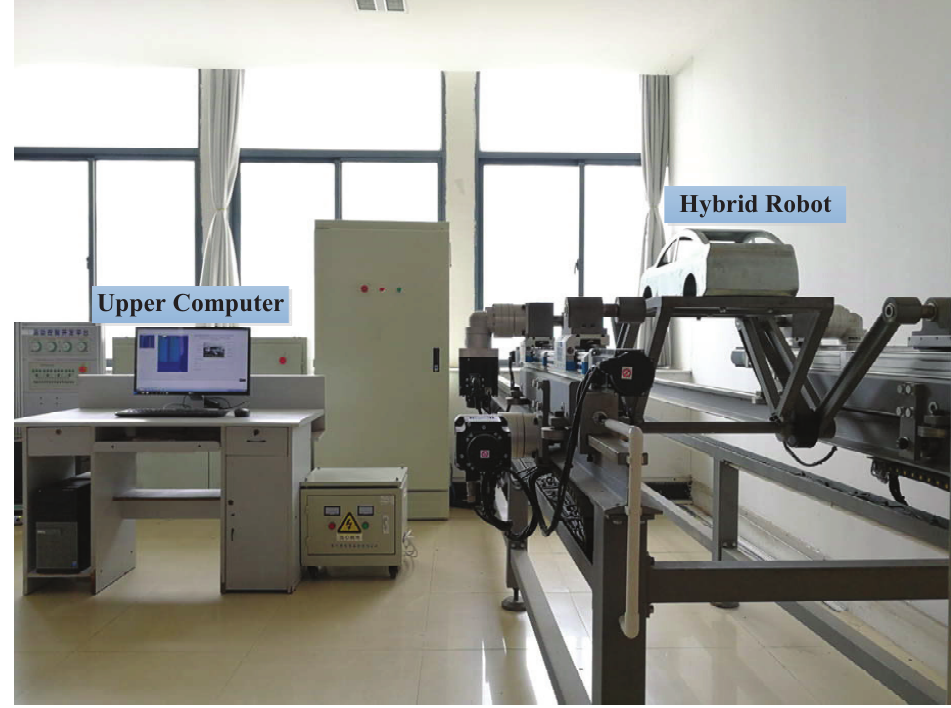
Figure 9. The prototype of the UBSHR system.